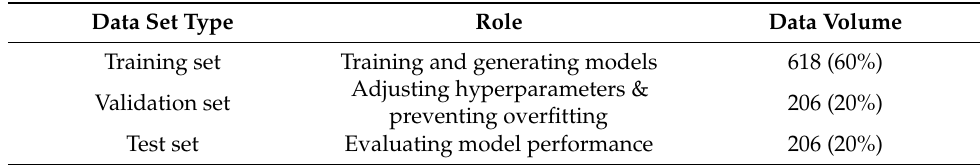
Figure 12. Database division. Table 6. Summary of the three